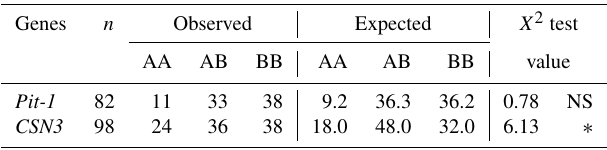
Table 5. Hardy–Weinberg genetic equilibrium test results of gene regions.